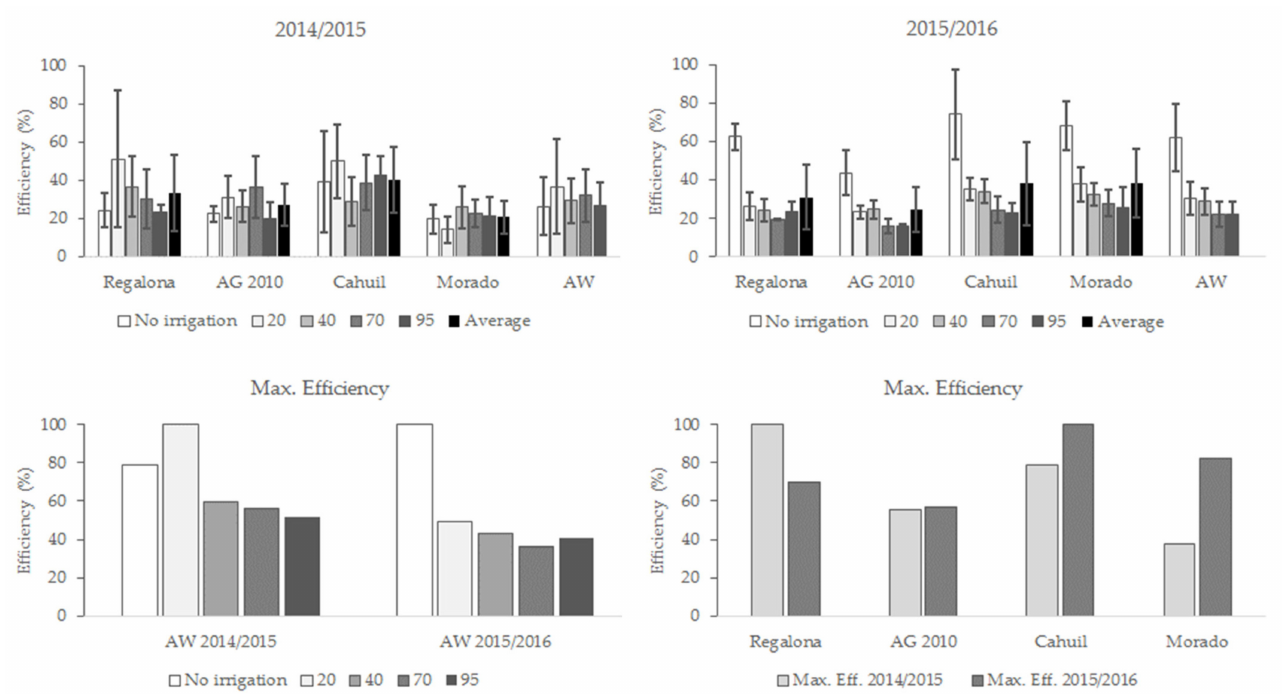
Figure 5. Average technical efficiency in globulin production in quinoa genotypes subjected to different water deficit conditions in 2014/2015 and 2015/2016 seasons.